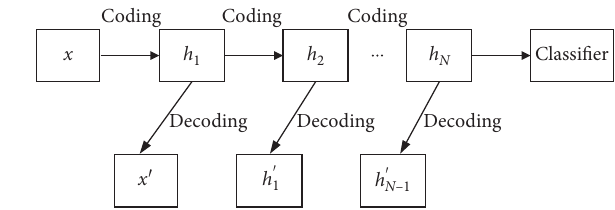
Figure 2: The network structure of